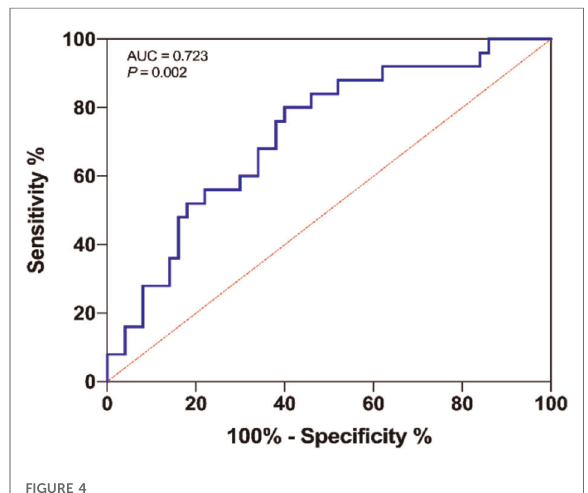
FIGURE 4 ROC curve showing the predictive ability of NLRP3 for PND in cardiac operation